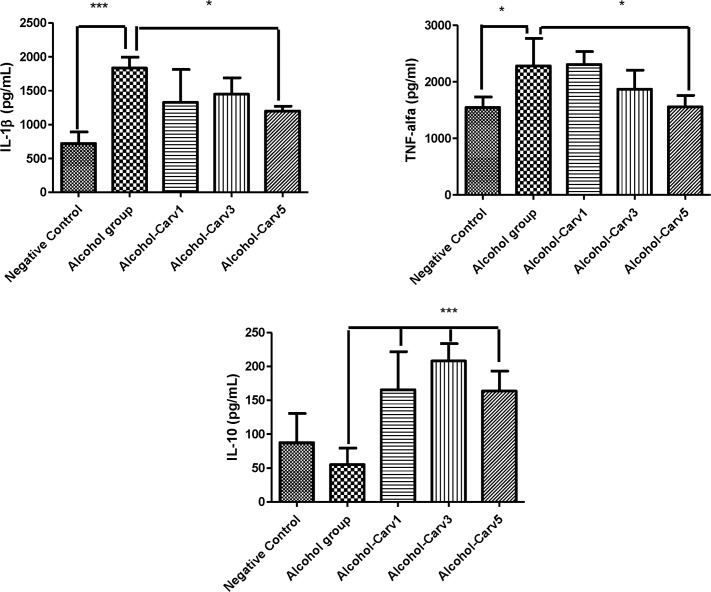
CARV counters alcohol-mediated effects on cytokine production in rats with alcohol-induced liver injury.Alcohol treatment elevated IL-1β (***p < 0.001) and TNF-α (**p < 0.01) levels, but reduced IL-10 levels (**p < 0.01), compared to the negative control group. CARV administration had a dose-dependent, alcohol-countering effect on IL-10 (5 mg/kg ***p < 0.001); only the 5 mg/kg dose of CARV had significant alcohol-countering effects on IL-1β (*p < 0.05) and TNF-α (5 mg/kg **p < 0.01) levels. Experiments were conducted in duplicate.